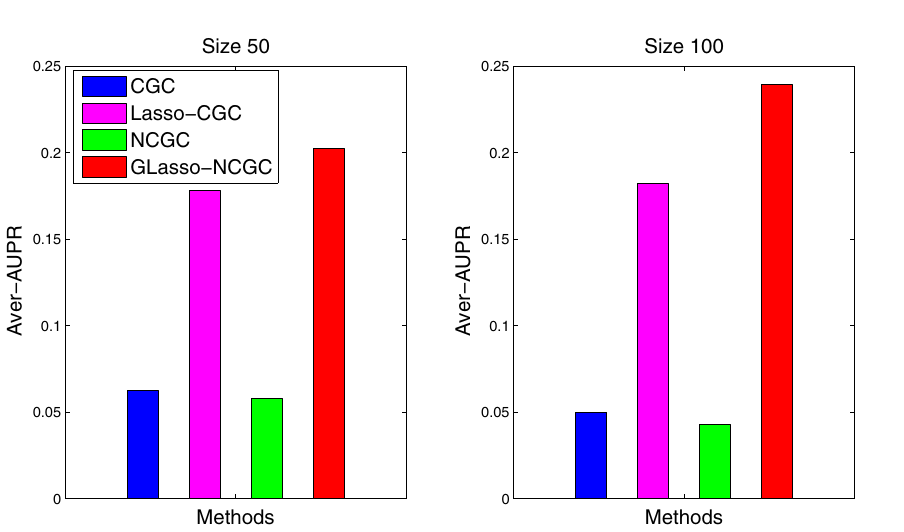
Figure 10. Average AUPR of different methods based on DREAM3 Challenge4 In-Silico networks with Size 50 and Size